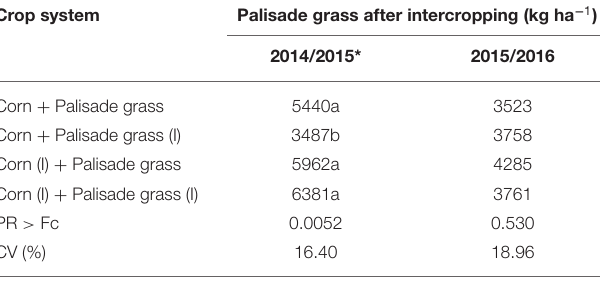
TABLE 5 | Dry matter yield of Palisade grass in an irrigated area after intercropped with corn in 2014/15 and 2015/16